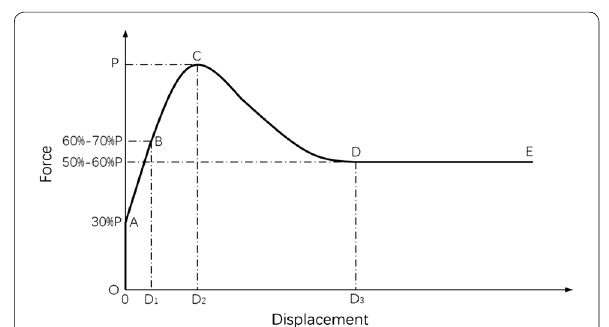
Fig. 8 Force and displacement behaviour